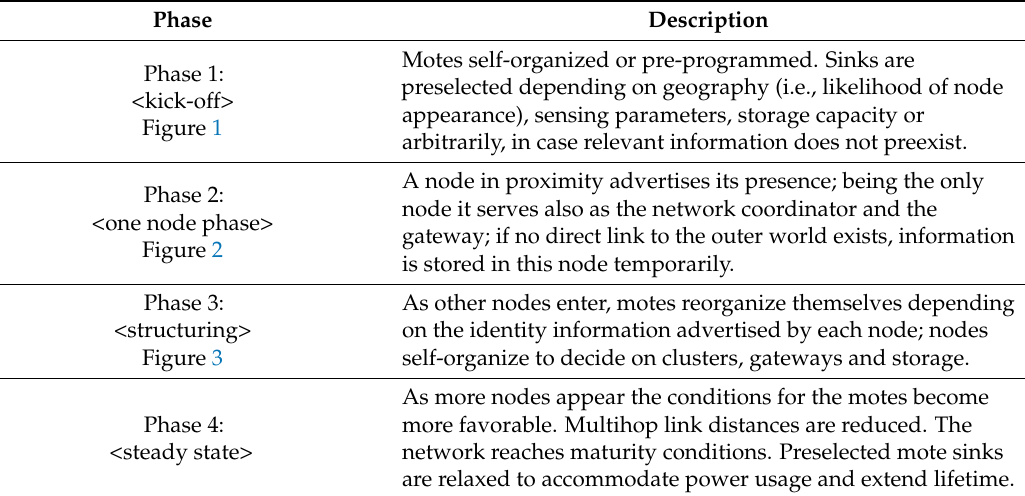
Table 1. The four different formation phases of the network.